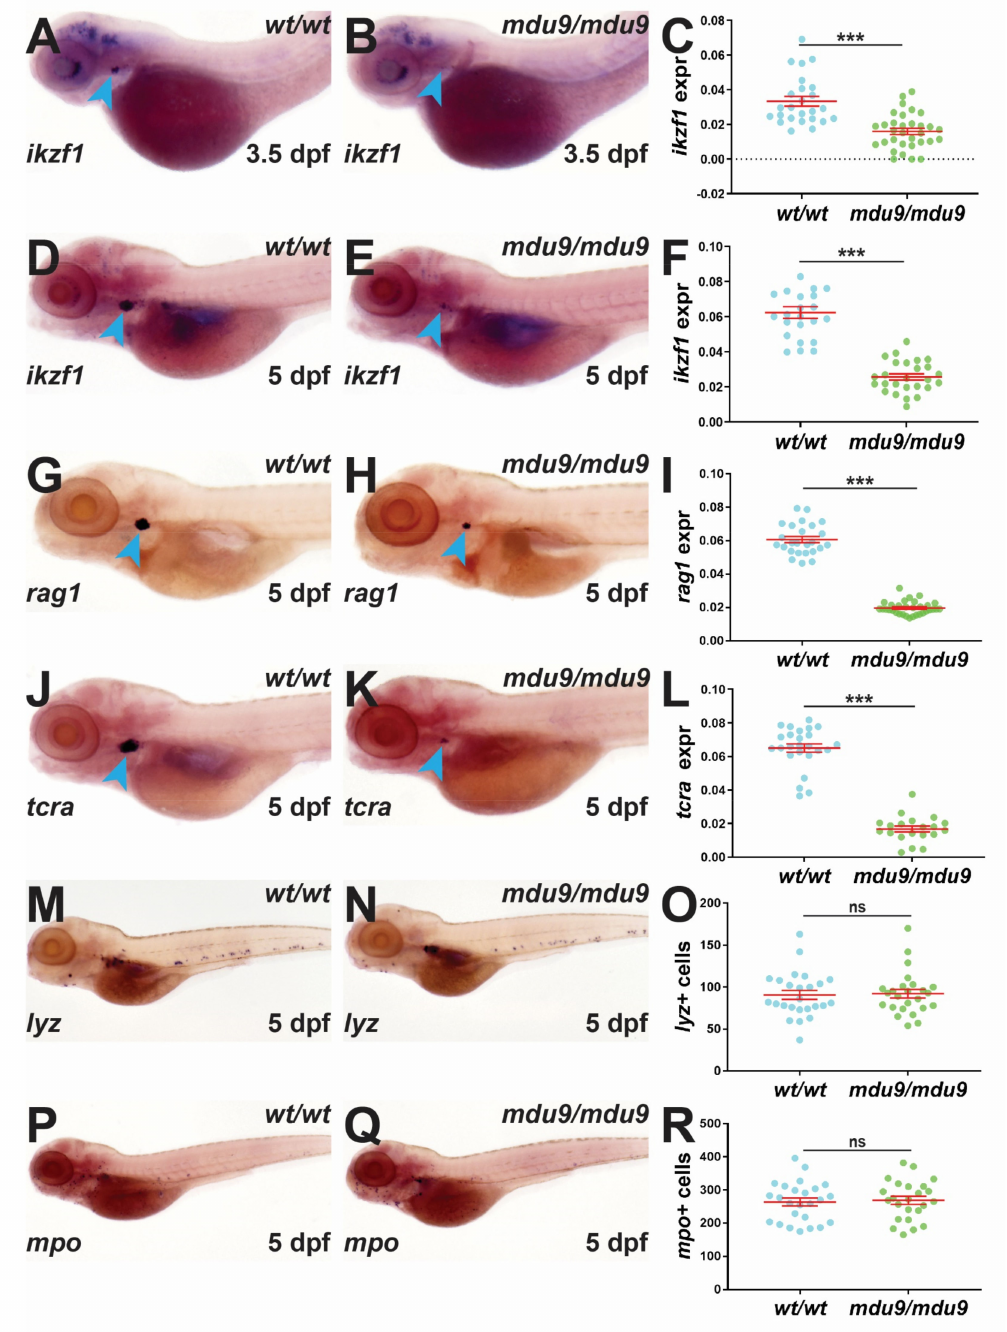
Figure 2. Analysis of embryonic zebrafish carrying Jak3 mutations. Analysis of immune cells in wild-type ( wt / wt ) and mutant ( mdu9 / mdu9 ) jak3 embryos using WISH with ikzf1 at 3.5 dpf ( A , B ) and 5 dpf ( D , E ), and rag1 ( G , H ), tcra ( J , K ), lyz ( M , N ) and mpo ( P , Q ) at 5 dpf. Representative embryos are shown with staining in the thymus indicated with blue arrowheads. Individual embryos were assessed for the area of expression for ikzf1 ( C , F ), rag1 ( I ) and tcra ( L ), expressed as a ratio to eye size averaged for individual embryos, or the number of lyz + ( O ) and mpo + ( R ) cells. Results for individuals are shown with the mean and SEM in red and level of statistical significance indicated (*** p < 0.001, ns not significant; n = 30). This result was confirmed in an additional